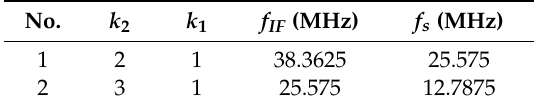
Figure 7. Detection probabilities with different sampling frequencies. Table 1. Sampling frequencies and intermediate